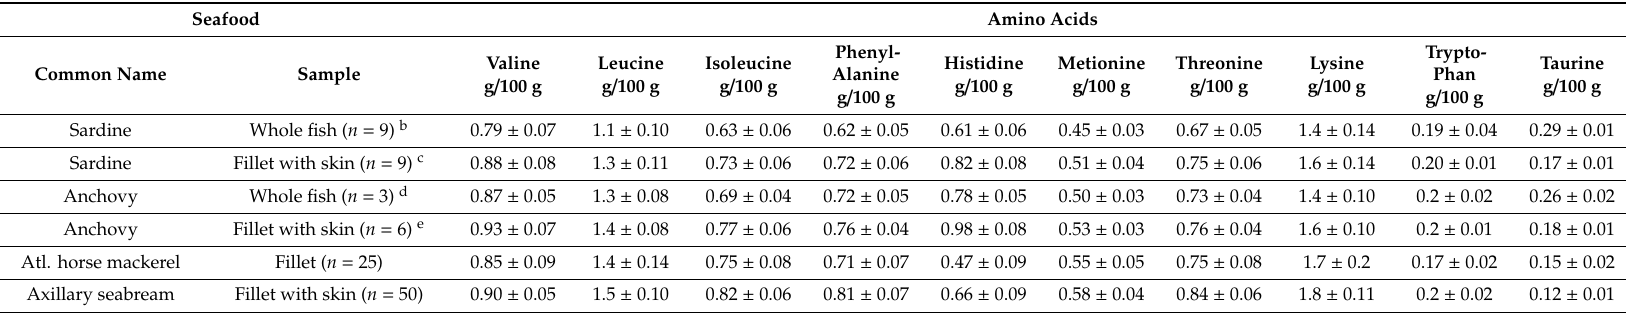
Table 5. Analytical values for selected amino acids in di ff erent species of fish sampled on the EAF Dr. Fridtjof Nansen cruise from Tangier to Cap Bojador in May 2017 (mean ± SD) a